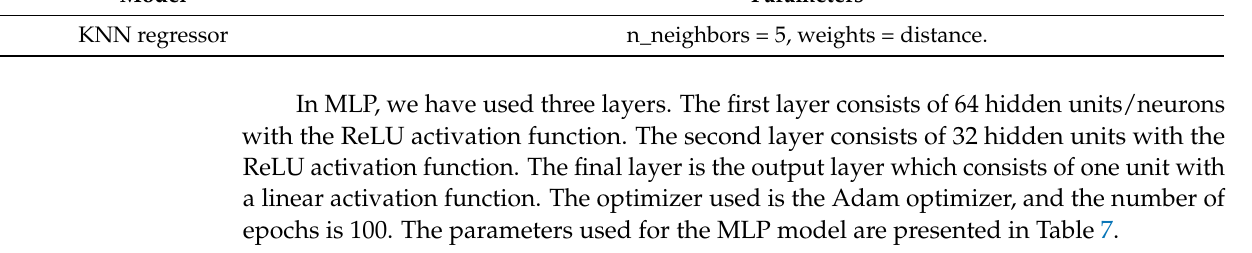
Table 7. Parameters for MLP model.